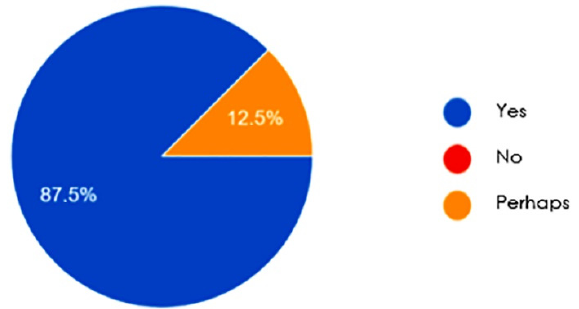
Figure 16. Results about connection between math and sustainability.